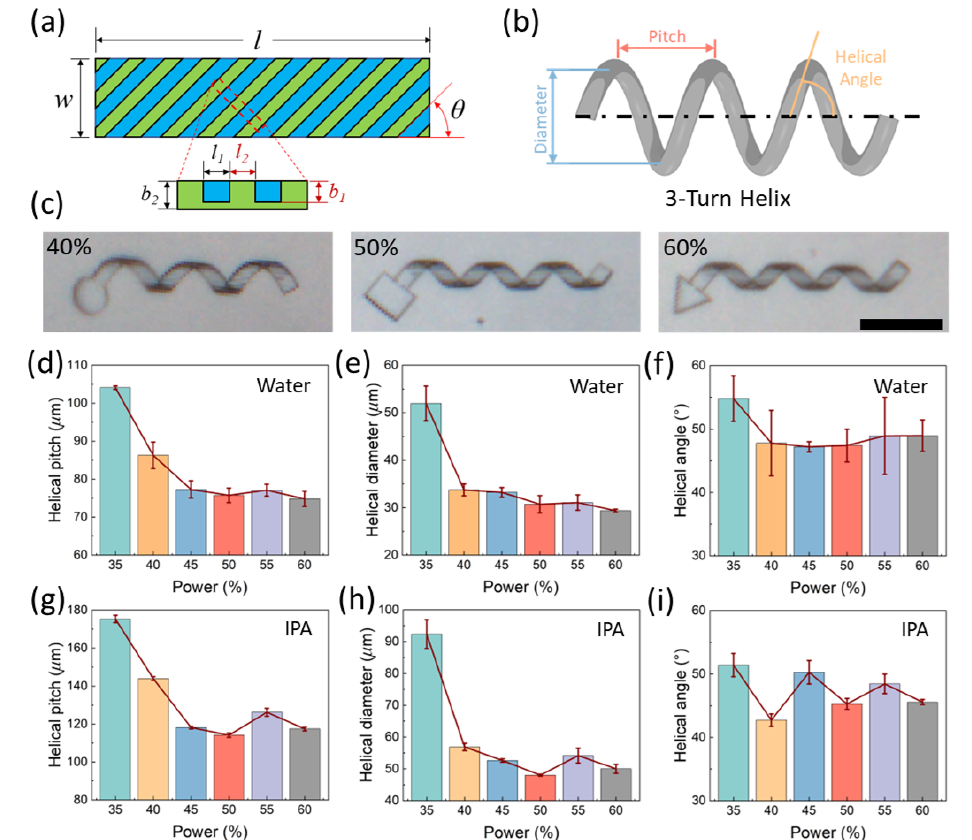
Figure 9. Indirect verification of the saturation at high power via 3D deformations. ( a ) Schematic of the modulating bilayer strip for 3D deformations. ( b ) Illustration of the helical parameters. ( c ) Deformed helical structures with different powers for the hard layer. Scale bar: 100 µ m. ( d – f ) Changes of helical parameters in water with different powers for the hard layer. ( g – i ) Changes of helical parameters in IPA with different powers for the hard